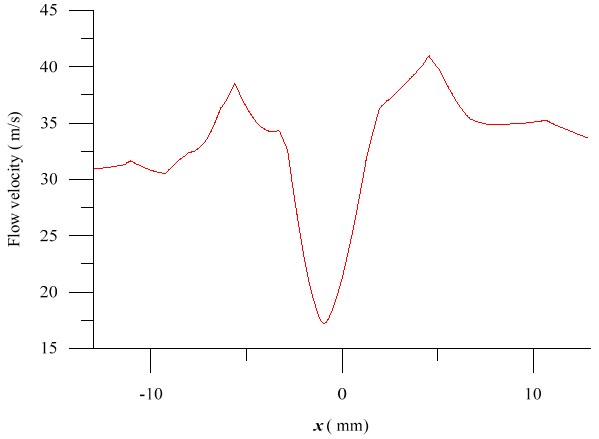
Figure 1. Numerical results of flow velocity distribution along x -direction from center of nozzle at 2 mm above surface of machining material for gas inlet pressure of 300 kPa and gas outlet pressure of 30 kPa.